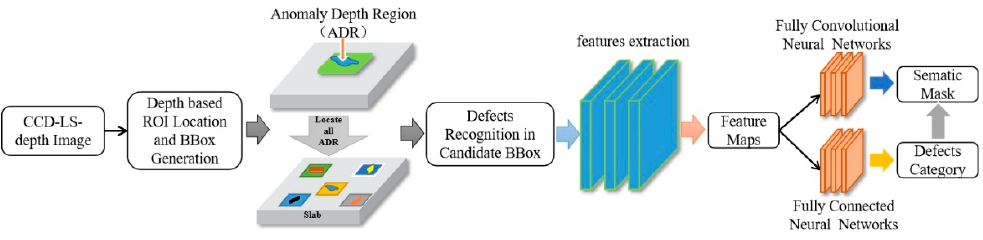
Figure 8. Defects recognition and delineation process based on deep CNN modeling mechanism.